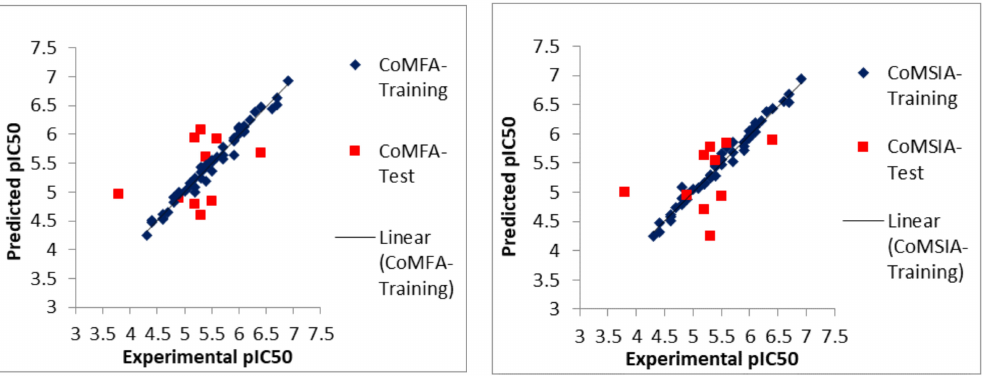
Figure 2. Experimental vs. predicted biological activities (pIC 50 ) values from best structure-based three-dimensional quantitative structure activity relationship (3D-QSAR)